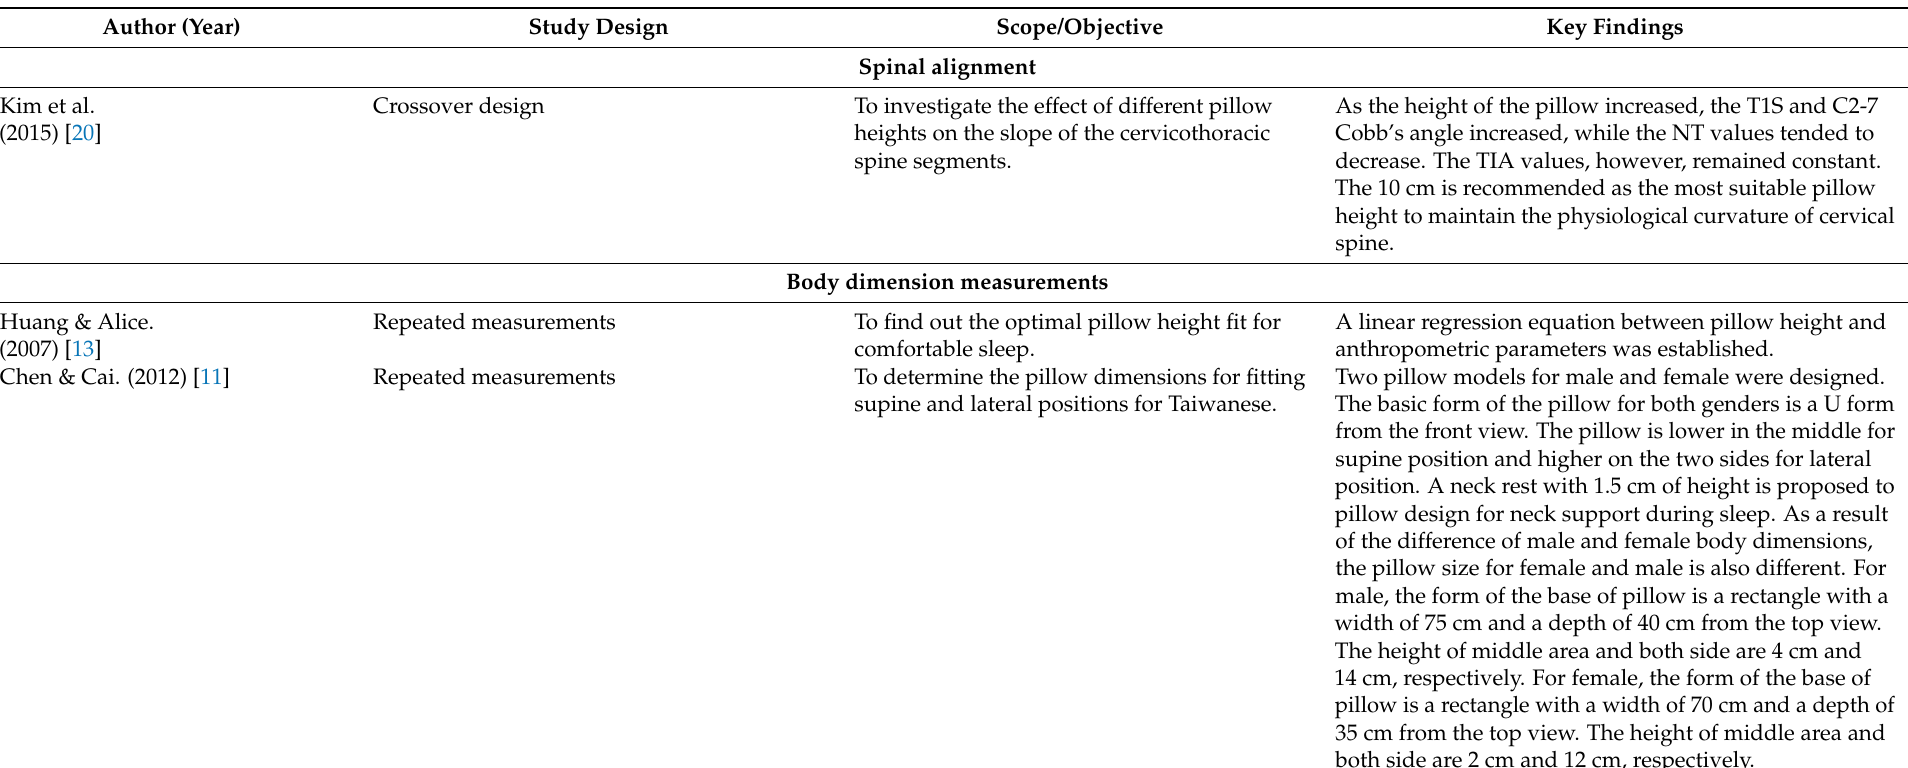
Table 3. Study scope and key findings of the reviewed